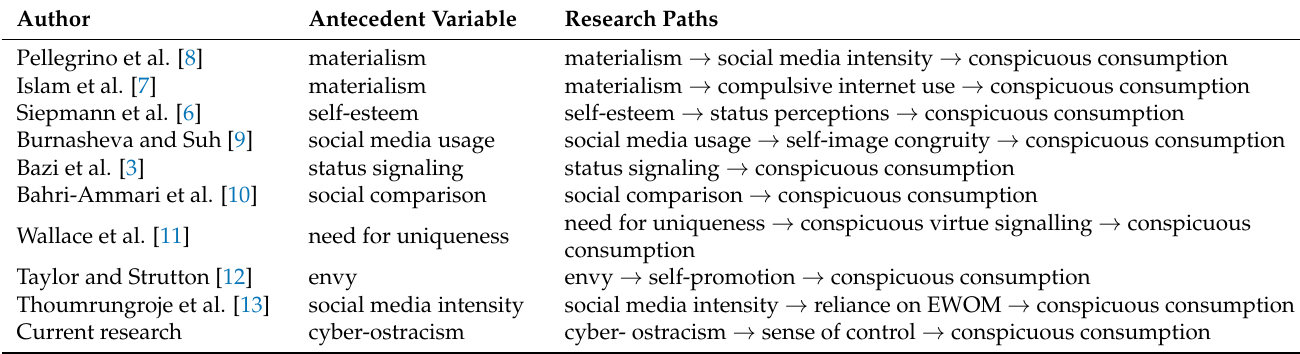
Table 1. Research related to conspicuous consumption in social media